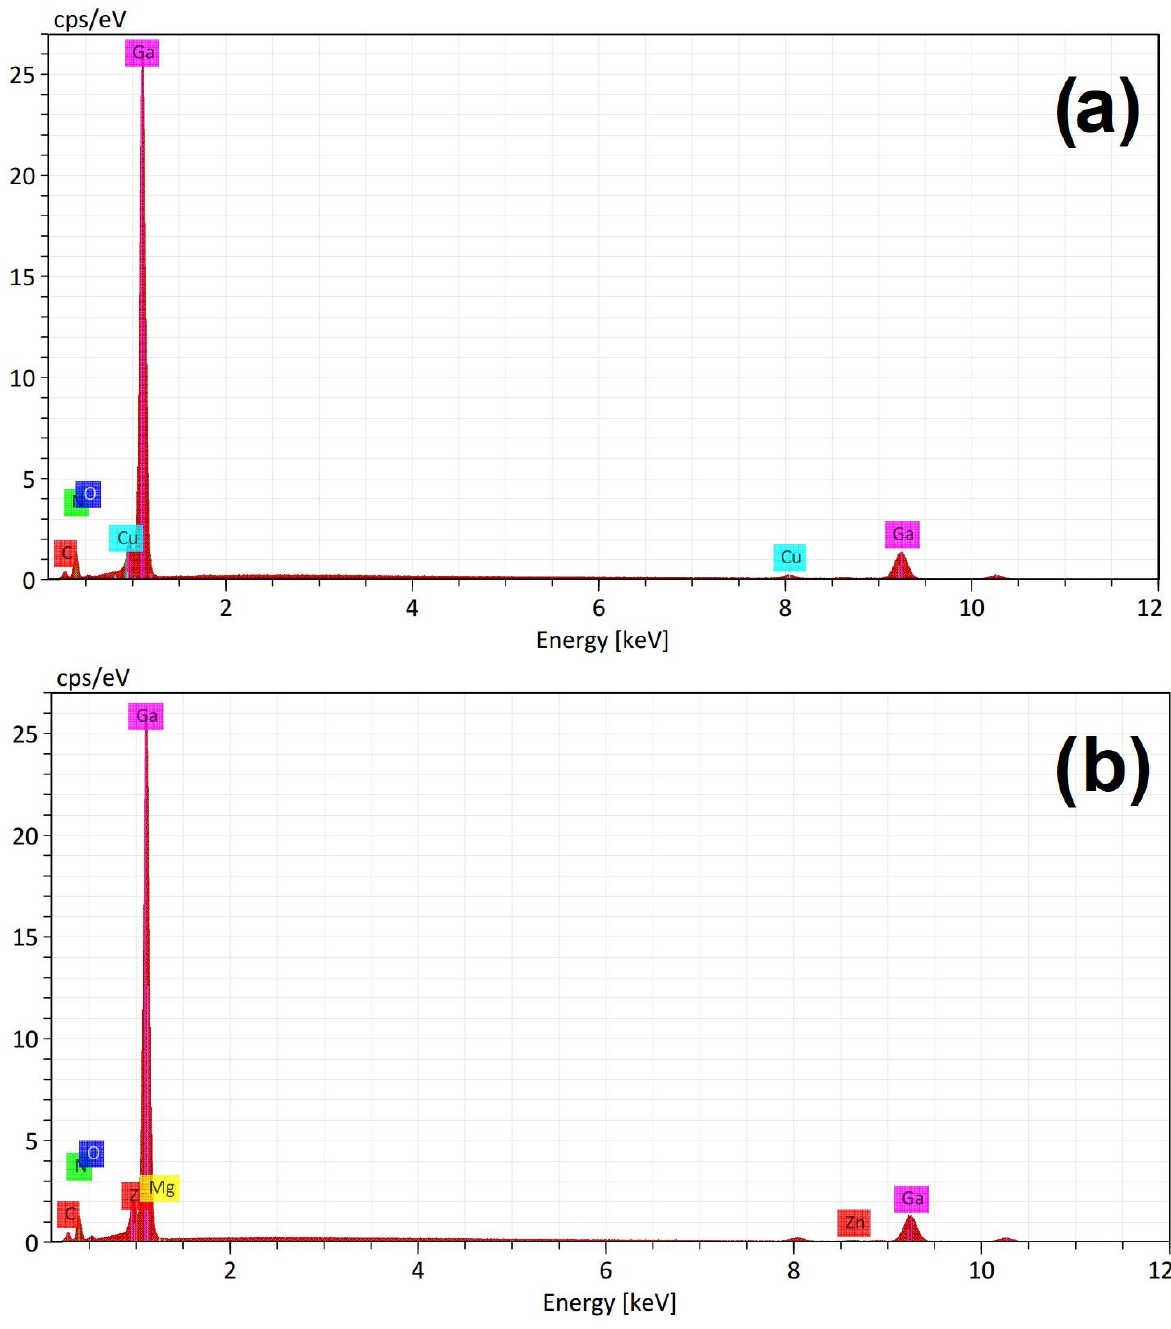
Figure 4. ( a ) EDS spectrum of SEM image of Figure 3a for the undoped GaN powders, ( b ) EDS spectrum of SEM image of Figure 3b for the Mg-Zn co-doped GaN powders.